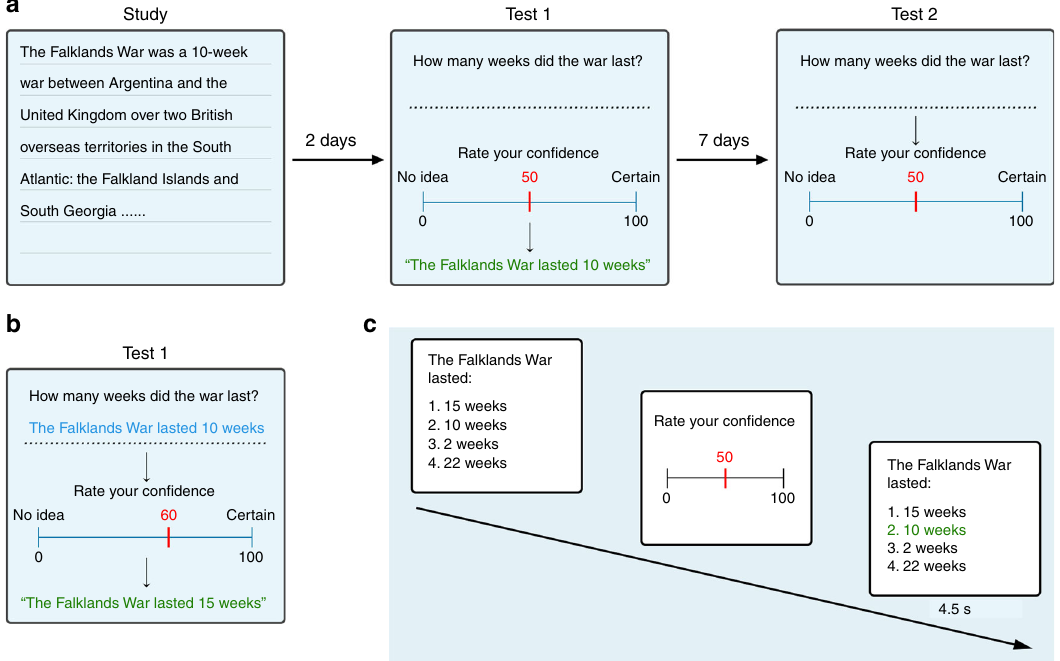
Fig. 1 Experimental paradigms of declarative knowledge acquisition and updating. a The experiments commenced with the study of a lengthy, factual text concerning an unfamiliar historical event. Participants were required to recall information from the text in a test 2 days later and state their con fi dence in each answer. Feedback (depicted in green) providing the correct answer (outcome) elicited PEs which were hypothesized to depend on the con fi dence ratings (expectation), such that an erroneous answer expressed with high con fi dence would engender a large negative PE and vice versa. For each trial, a PE term was calculated as the additive inverse of the con fi dence ( – con fi dence) for incorrect answers, and 100-con fi dence for correct answers